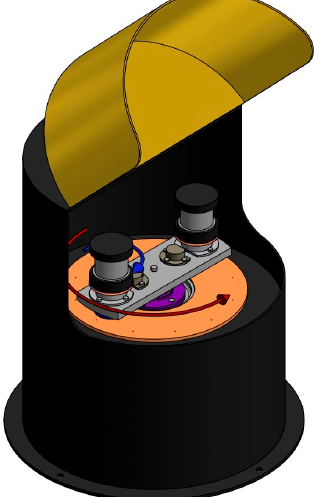
Figure 3. Sketch of the planetary mill designed with a protective external structure.